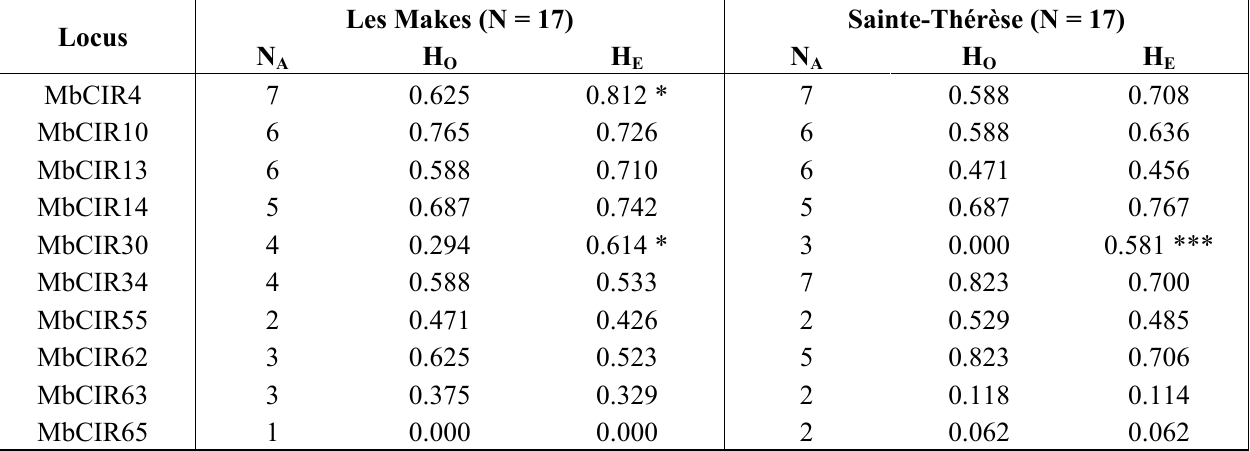
Table 2. Genetic diversity revealed by ten microsatellite loci in two natural populations of Mimusops balata . N Number of individuals tested; N Number of alleles detected; H A O Observed heterozygosity; H Expected heterozygosity; Significant deviation from E Hardy-Weinberg equilibrium:* p < 0.05, *** p <